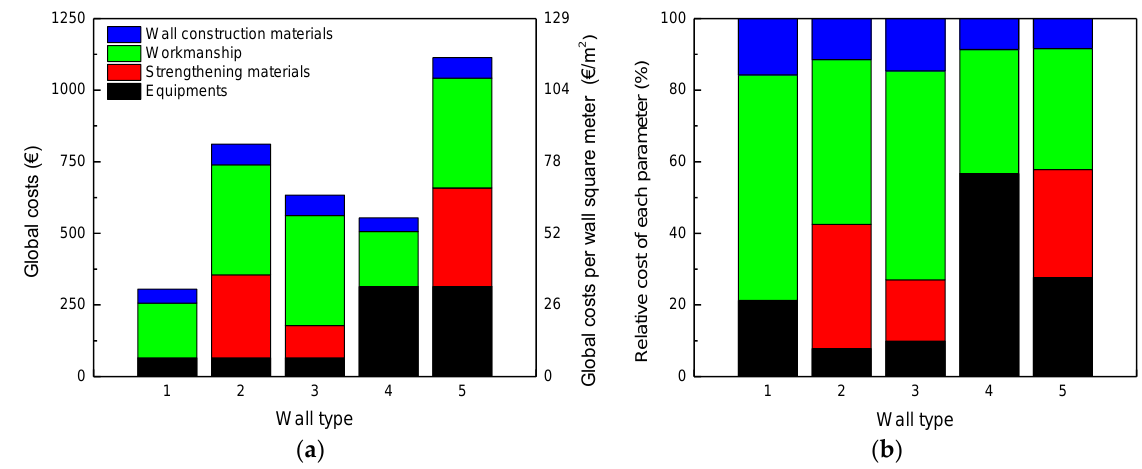
Figure 11. Cost analysis: ( a ) global costs; ( b ) relative cost of each parameter.